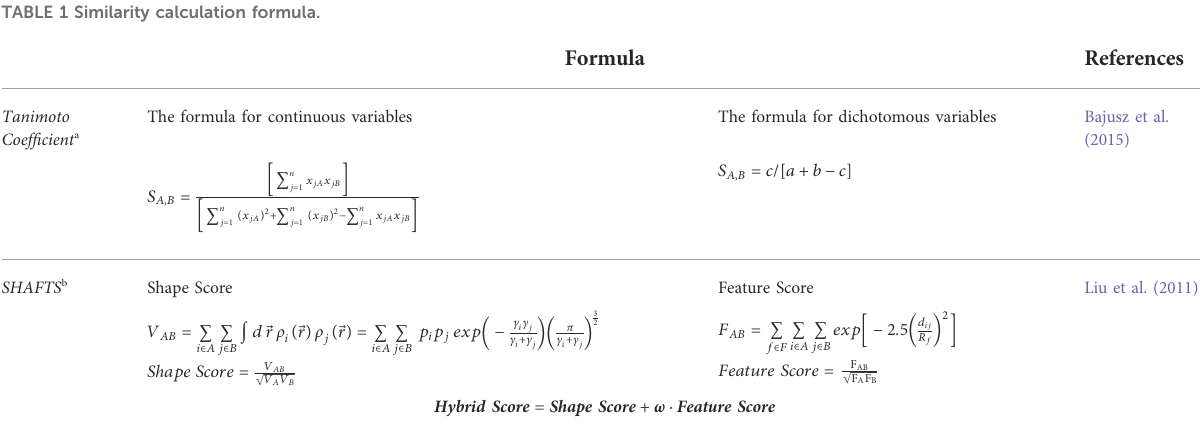
TABLE 1 Similarity calculation